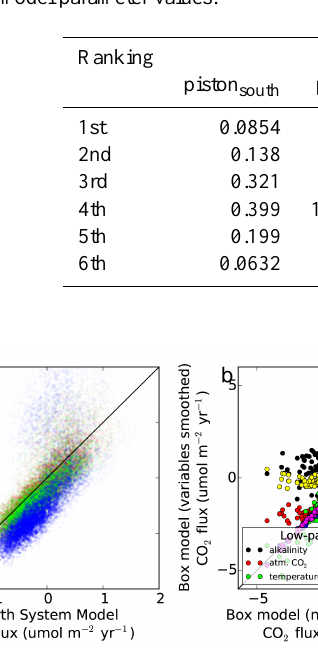
Figure 4. (a) ESPPE subpolar North Atlantic air–sea CO 2 flux anomaly plotted against box model estimates of that same flux using the top three box model parameter sets (Table 2) in red, blue and green respectively. (b) Results from box model driven with low-frequency variability in all input variables, plotted against: box model results when low-frequency alkalinity signal is removed (black), low-frequency atmospheric CO 2 signal removed (red), low-frequency temperature signal removed (green), low-frequency salinity signal removed (blue), low-frequency meridional overturn- ing circulation (MOC) signal removed (purple), and low-frequency atmospheric CO 2 concentration, alkalinity and temperature signals all removed. The straight line represents the one-to-one line upon which results would fall if removal of the low-frequency variability in that variable did not influence CO 2 uptake.